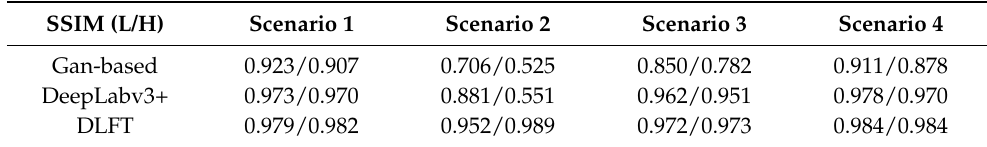
Table 3. Comparison of different network